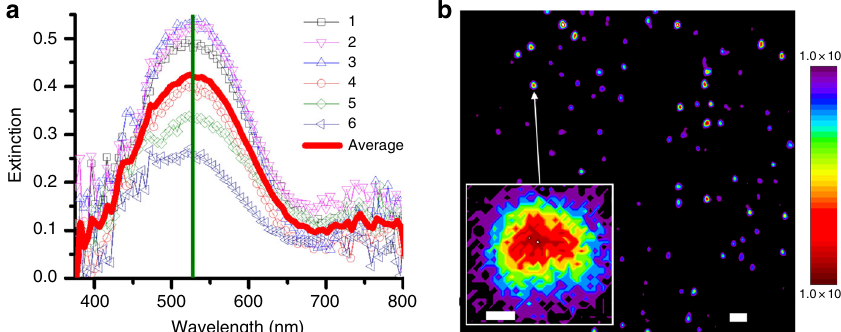
Fig. 4 Plasmonic properties of the spherical coral-shaped gold nanoparticles induced by Pep-1. a Hyperspectral UV-Vis extinction of six individual particles revealing well-de fi ned plasmon resonances centered at ~528 nm. b Three-photon photoemission electron micrograph of a sparse distribution of particles showing the photoemission enhancement map (scale bar, 50 nm), in which a single-coral-shaped particle (the insert) exhibited a plasmonic enhancement as high as 10 5 (scale bar, 20